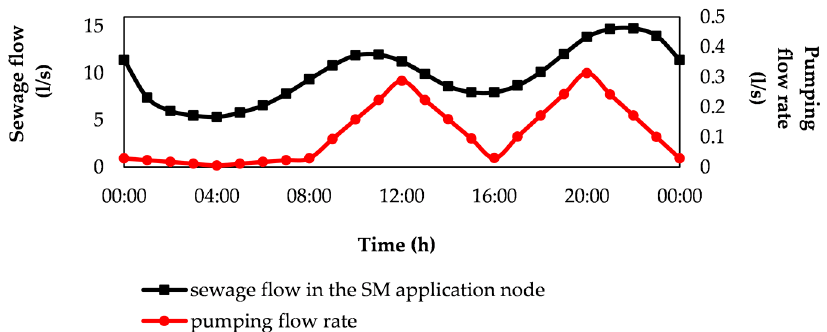
Figure 18. Hourly fluctuations of sewage flow in the optimal node and of pumping flow rate. The figure concerns a scenario with moderate hydrogen sulfide production in the network pipes.